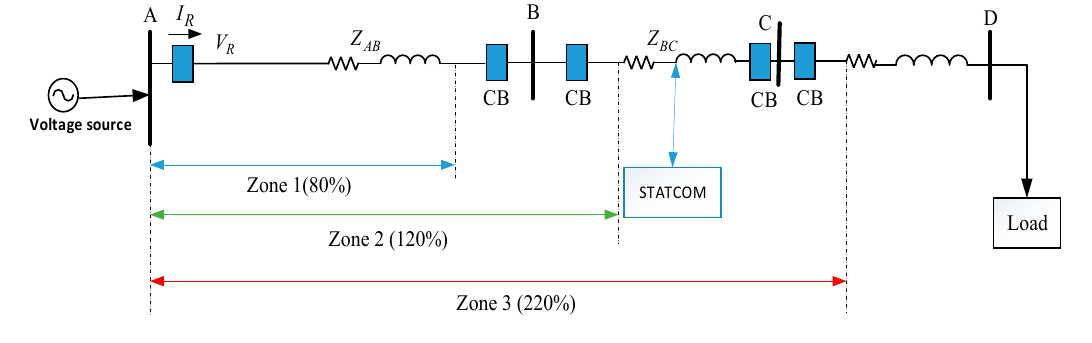
Figure 1. Power System Model.